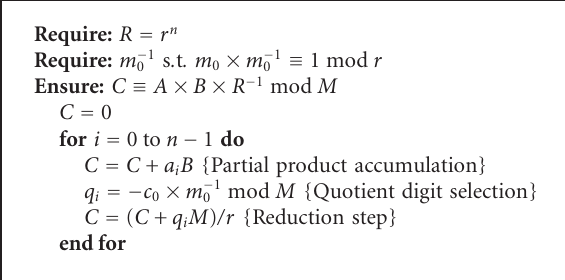
Algorithm 3: Montgomery modular